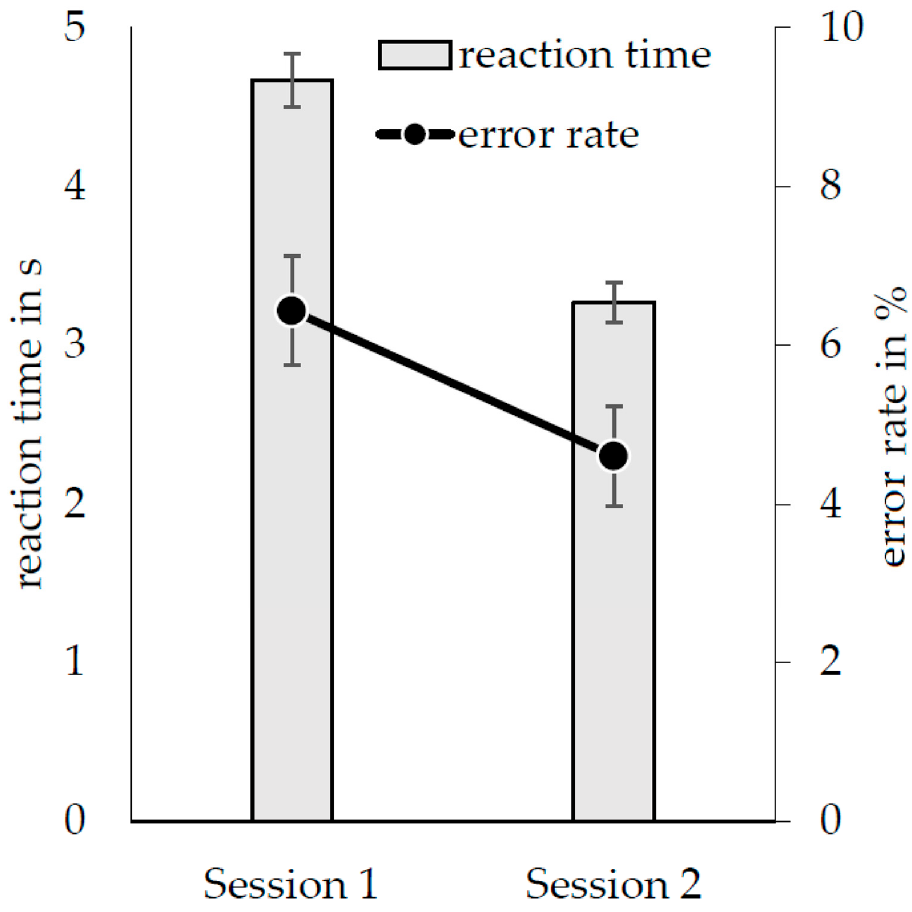
Figure 4. Means and standard errors of reaction times (in seconds) and error rates (in %) in Session 1 and Session 2.